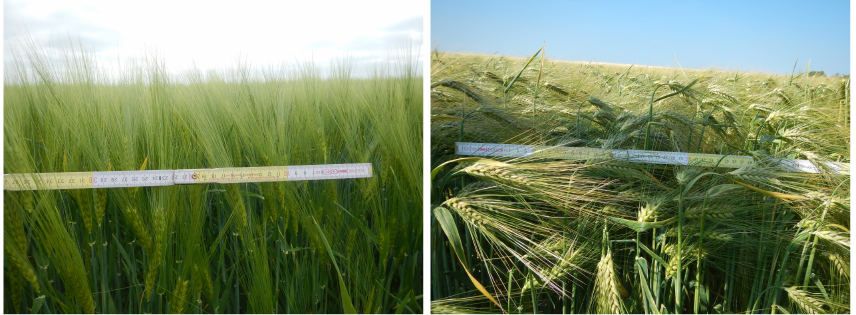
Figure 7. Barley field “H” at 18th of May 2018 ( left ) and barley field “H” at 6th of June 2018 ( right